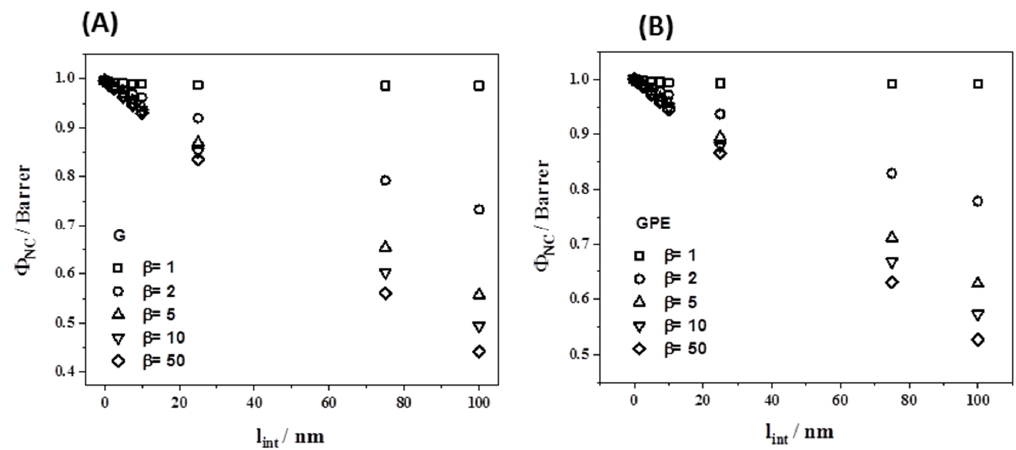
Figure 10. Dependence of NC for oxygen permeation with the interface thickness ( l int ) of rigidified polymer regions around the filler for the nanocomposites with G ( A ) and GPE ( B ). The simulation was made using the experimental value of 1.02 Barrer for Φ p .